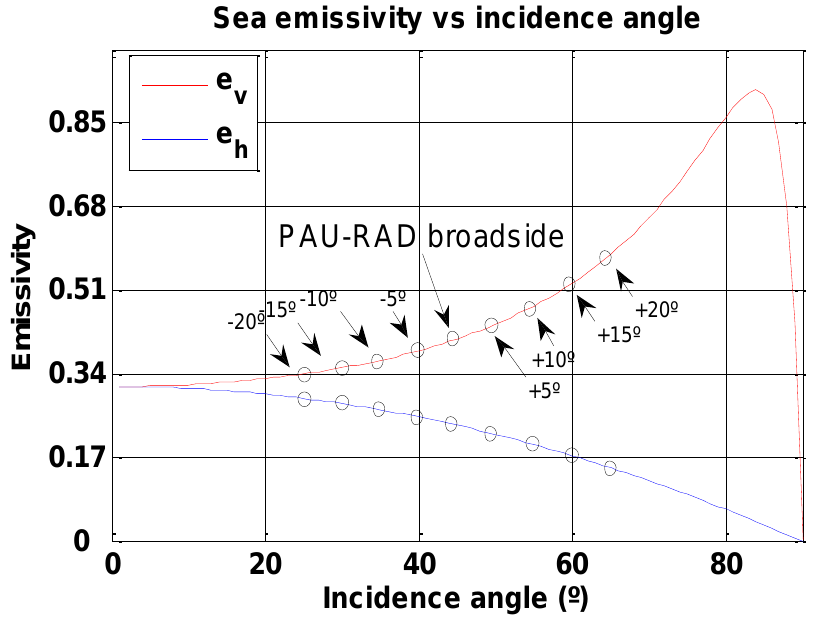
Figure 1. Vertical and horizontal emissivities vs. incidence angle. PAU-RAD antenna boresight pointed at 45° and with the digital beamforming signal processing technique creates beams from 30° to 60° incidence angles in 5° steps. The emissivity curve corresponds to a calm sea with T = 293 K, SSS = 36 psu and at f = 1,575.42 sea GPS-L1